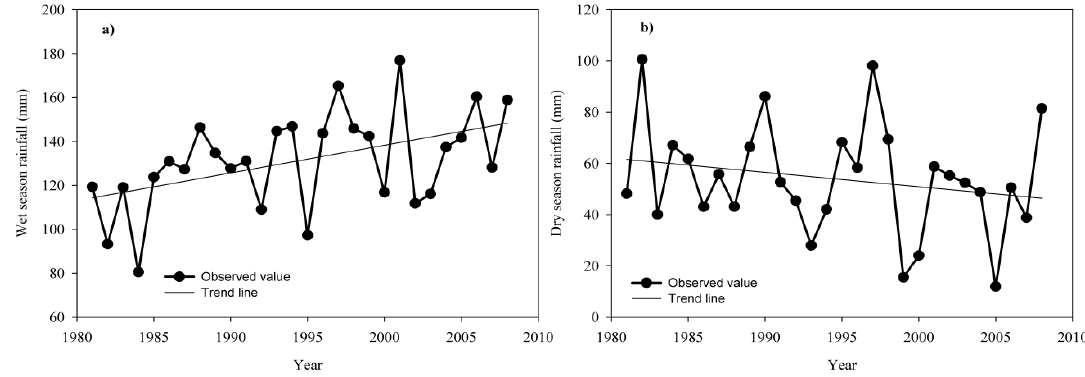
Figure 5. Seasonal rainfall trends for selected stations: ( a ) Wet season at Assendabo and ( b ) dry season at Shebe .